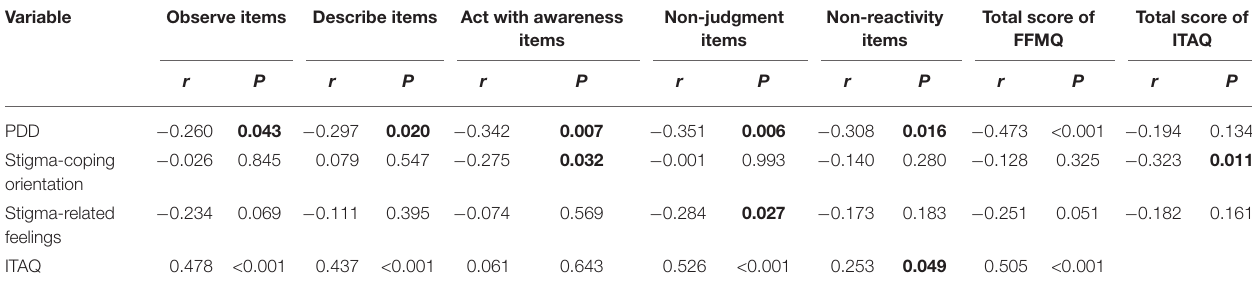
TABLE 6 | Correlation analysis of mindfulness level with stigma, insight and treatment